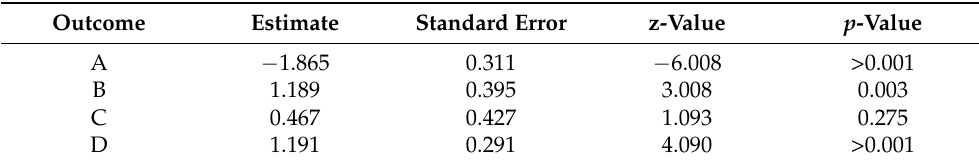
Table 3. Results of the GLMM testing the effect of outcome on the likelihood of expressing aggressive behavior within 3 min after